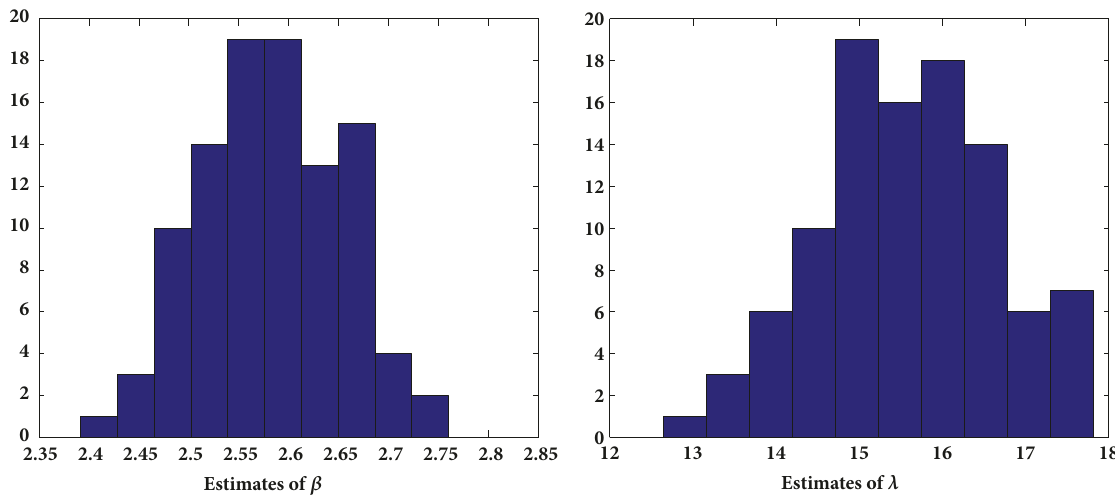
Figure 2: Histograms of 100 estimators of 𝛽 = 2.6 and 𝜆 = 15 with 𝑑 = 5,𝑃 𝜏 = 1/5 (1 ≤ 𝜏 ≤ 5) and 𝑁 = 10 4 . The starting values are 𝑖(𝑡) = 10(1 ≤ 𝑡 ≤ 5),𝑆(0) = 𝑁 .